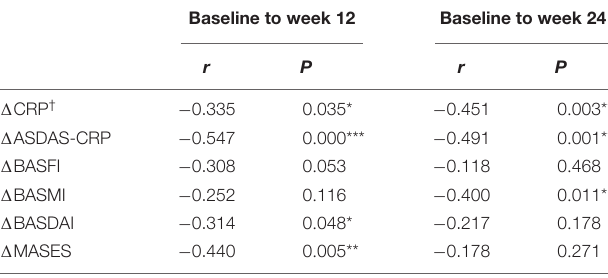
TABLE 4 | Correlations between percentage changes in RBP4 levels and changes in clinical parameters from baseline to week 12 and week 24. Baseline to week 12 Baseline to week